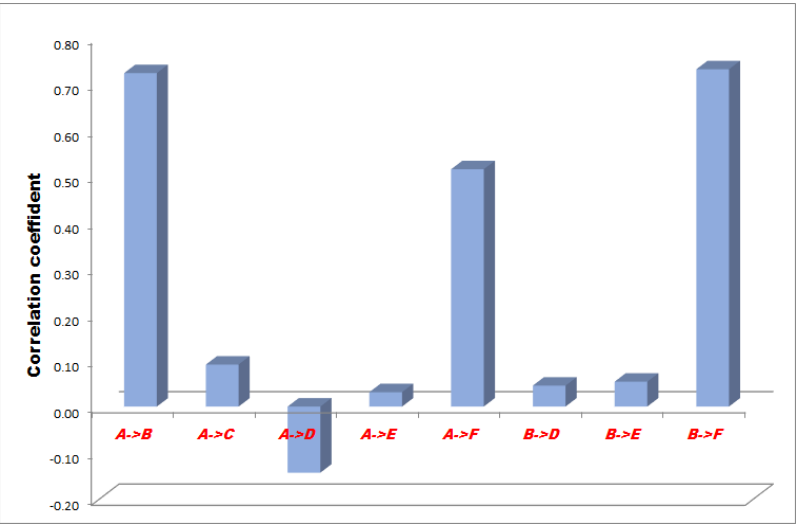
Figure 3. Results of statistical (correlation) analysis between the different sensor pairs during Negative pressure wound therapy (NPWT) applying at 50 mmHg suction. Sensors represent exact measurement points in the abdominal cavity. A: midline, above the layer; B: midline, under the layer; C: laterally, above the layer; D: laterally, under the layer; E: midline, among the bowels; F: laterally, among the bowels.